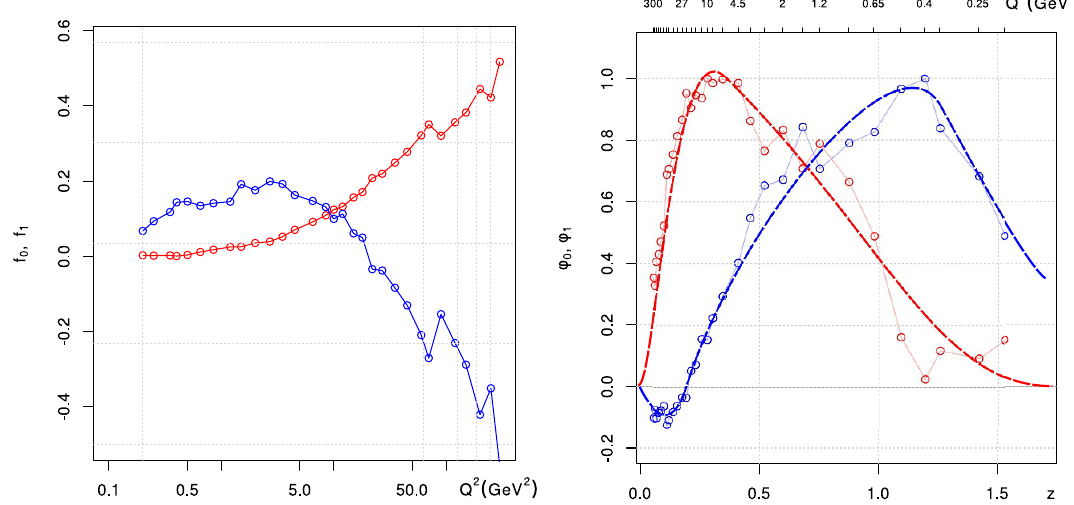
Figure 4 . Hard (red) and soft (blue) pomerons guess from data. Left panel presents the plots of f 0 ; 1 ( Q ) similar to [4]. The right panel shows the associated wavefunctions 0 ; 1 ( z ), after considering the prefactor suggested by the gauge/gravity duality. The values j 0 = 1 : 26, j 1 = 1 : 08 have been used, close to what we (cid:12)nd later in the paper. Clearly the shape of the wave functions is that of a ground state and of a (cid:12)rst excited state of some Schr(cid:127)odinger